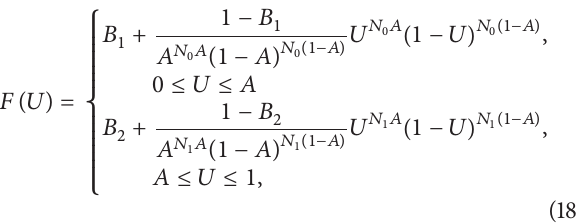
polynomial for arc arrays [5] is extended to 3D case to be